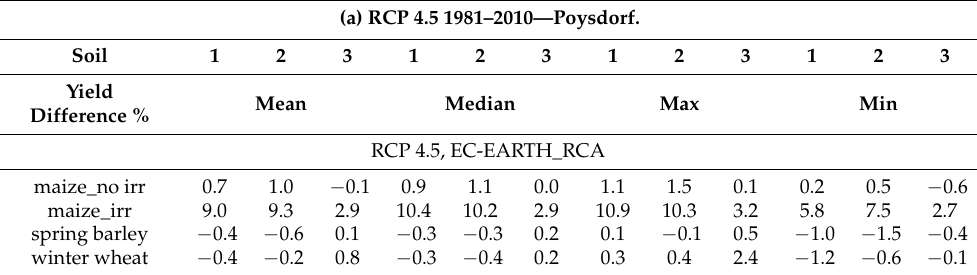
Table A5. Mean, Median, Maximum (Max), and Minimum (Min) values for yield differences (%) across 5, 11, and 21 km aggregated data in maize (rainfed = no irr, optimally irrigated = irr), winter wheat, and spring barley (rainfed) grown on three different soils; 1 km input data vs. aggregated data of three ÖKS15 projections in RCP 4.5 (EC-Earth_RCA, IPSL_RCA and HadGEM_CLM) in Poysdorf, Bad Gleichenberg and Kremsmünster for the (a) baseline and (b) 2071–2100